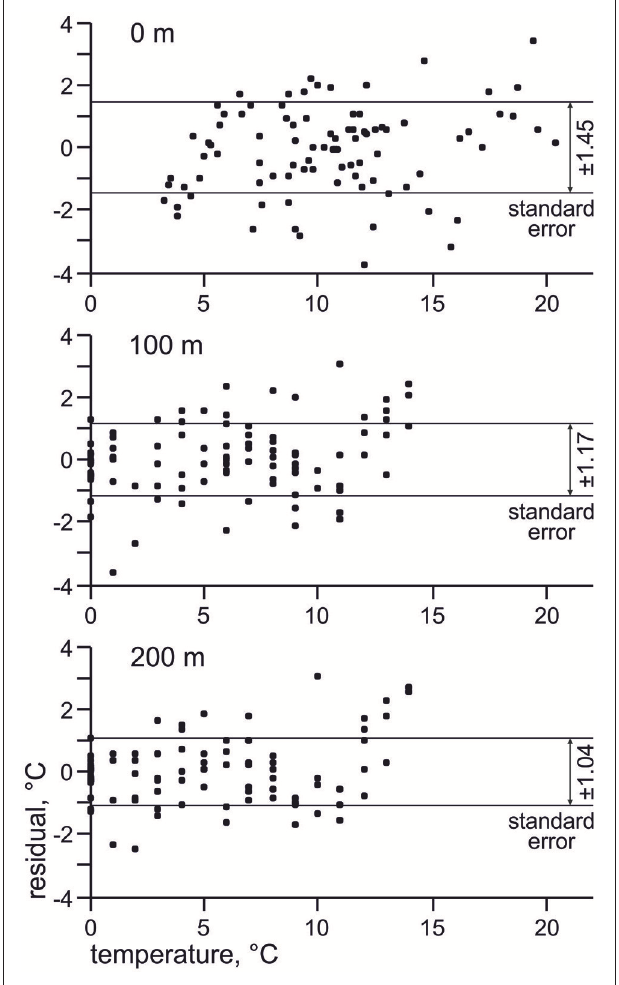
FIGURE 7 | Residuals (estimated minus measured temperature) and standard errors of estimated temperature. Horizontal axis present measured temperature from the World Ocean Atlas 2013 (Locarnini et al.,